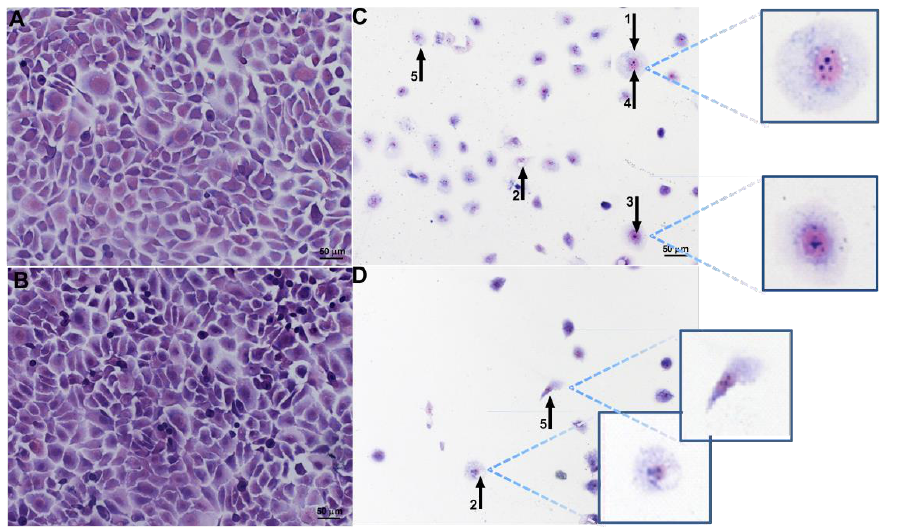
Figure 8. Morphological changes of SCC-25 cells assessed by Giemsa staining, after 24 h of treatment. ( A ) Negative control; ( B ) Vector control (hydrogel without VADE) at higher concentration; ( C ) VADE-loaded-hydrogel at the concentration of 250 µg/mL and ( D ) 500 µg/mL. The arrows and insets in Figures C and D highlight the most important cellular morphological alterations, such as: 1 — rounding and swelling; 2 — vacuoles; 3 — chromatin condensation; 4 — chromatin fragmentation; 5- lysis. The intensive cellular lysis was detected at a higher concentration of VADE-loaded-hydrogel ( D ). Scale bars = 50 µm.